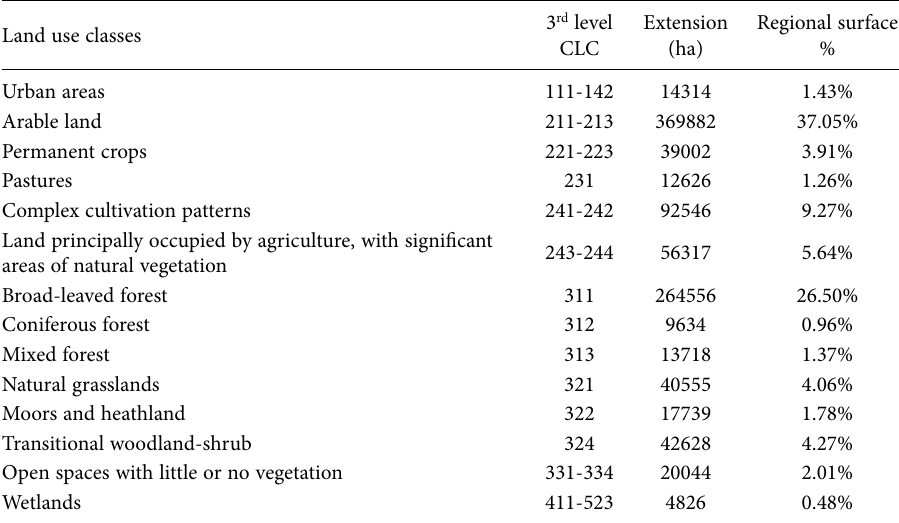
Table 2. Land use classes considered in the